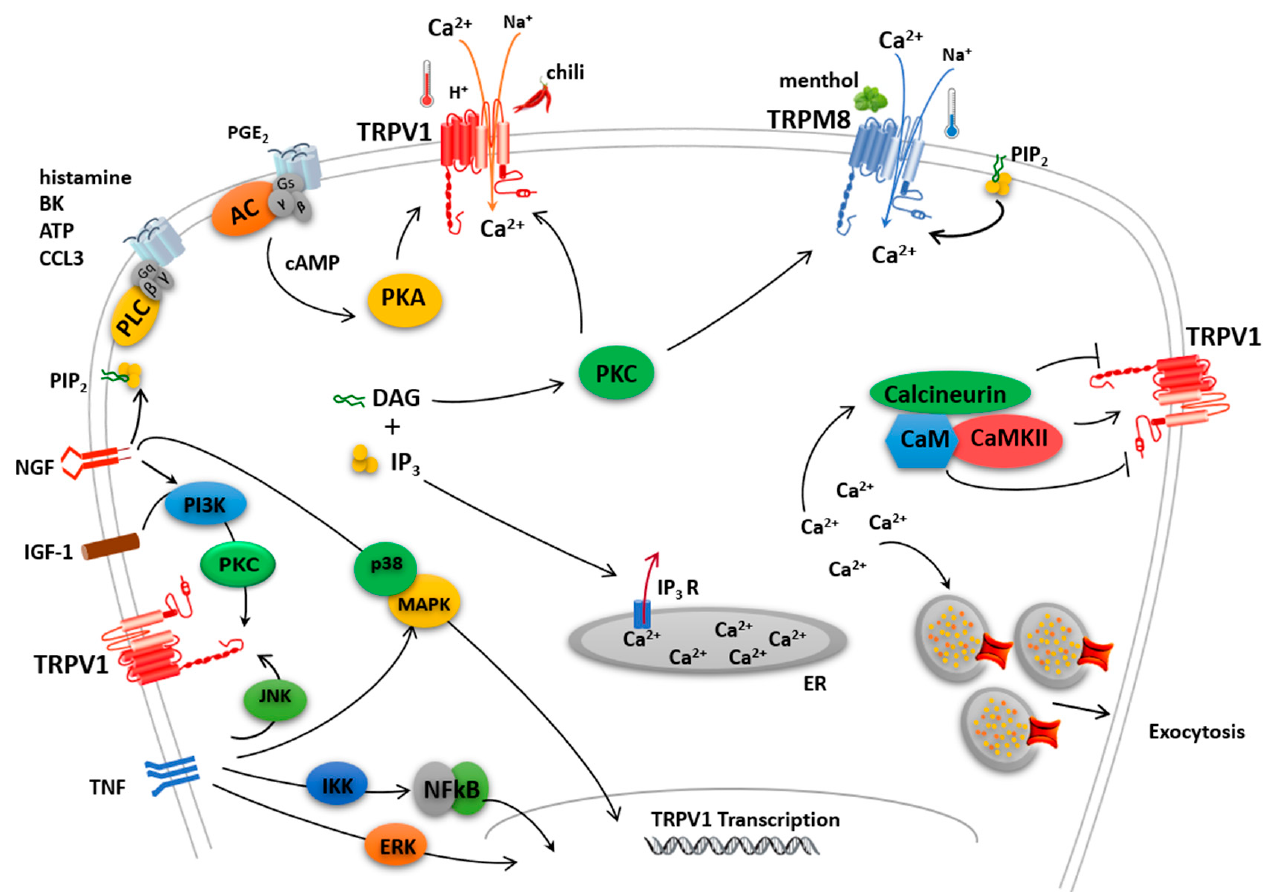
Figure 2. Polymodal TRPV1 and TRPM8 modulation. TRPV1 and TRPM8 channels show multimodal gating being activated not only by temperature but also by different exogenous and endogenous compounds. The activation of these ion channels may also increase neuron excitability through the activation of intracellular signaling pathways. TRPV1 sensitization appears mediated by direct phosphorylation of intracellular protein domains by PKC, PKA, and other kinases. A dynamic balance between phosphorylation and dephosphorylation of TRPV1 by Ca 2+ /calmodulin-dependent kinase II and calcineurin, respectively, appears to control the activation/desensitization state of the channel. TRPV1 activity may be additionally potentiated by Ca 2+ -induced exocytotic recruitment to the cell membrane of an internal pool of vesicular TRPV1. TRPM8 sensitization is modulated by phosphoinositide PIP 2 and also by direct phosphorylation of intracellular protein domains by PKC. Despite the structural data accrued thus far, the available atomic information does not suffice yet to define a general mechanism of thermoTRP polymodal channel gating shared by the family members. Most likely, the ability to sense a variety of stimuli and the divergent structural features of the N- and C-terminus may prevent a single, conserved activation mechanism in these channels, although for temperature sensing, a common hy- pothesis has been proposed [16]. Additionally, the solved structures reveal great diversity in ligand binding and modulators of thermoTRP channels. Complementarily, the study of orthologous TRP channels from different species has yielded contradictory functions, indicating that these channels have evolved to adapt to the needs of a species in its environ- mental niche [17]. For instance, TRPA1 in mammals appears to be gated by cold, while